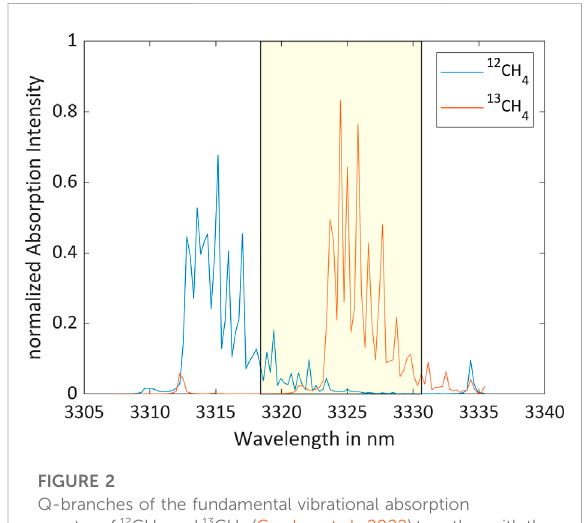
FIGURE 2 Q-branches of the fundamental vibrational absorption spectra of 12 CH 4 and 13 CH 4 (Gordon et al., 2022) together with the tuning range of the ICL (yellow box).